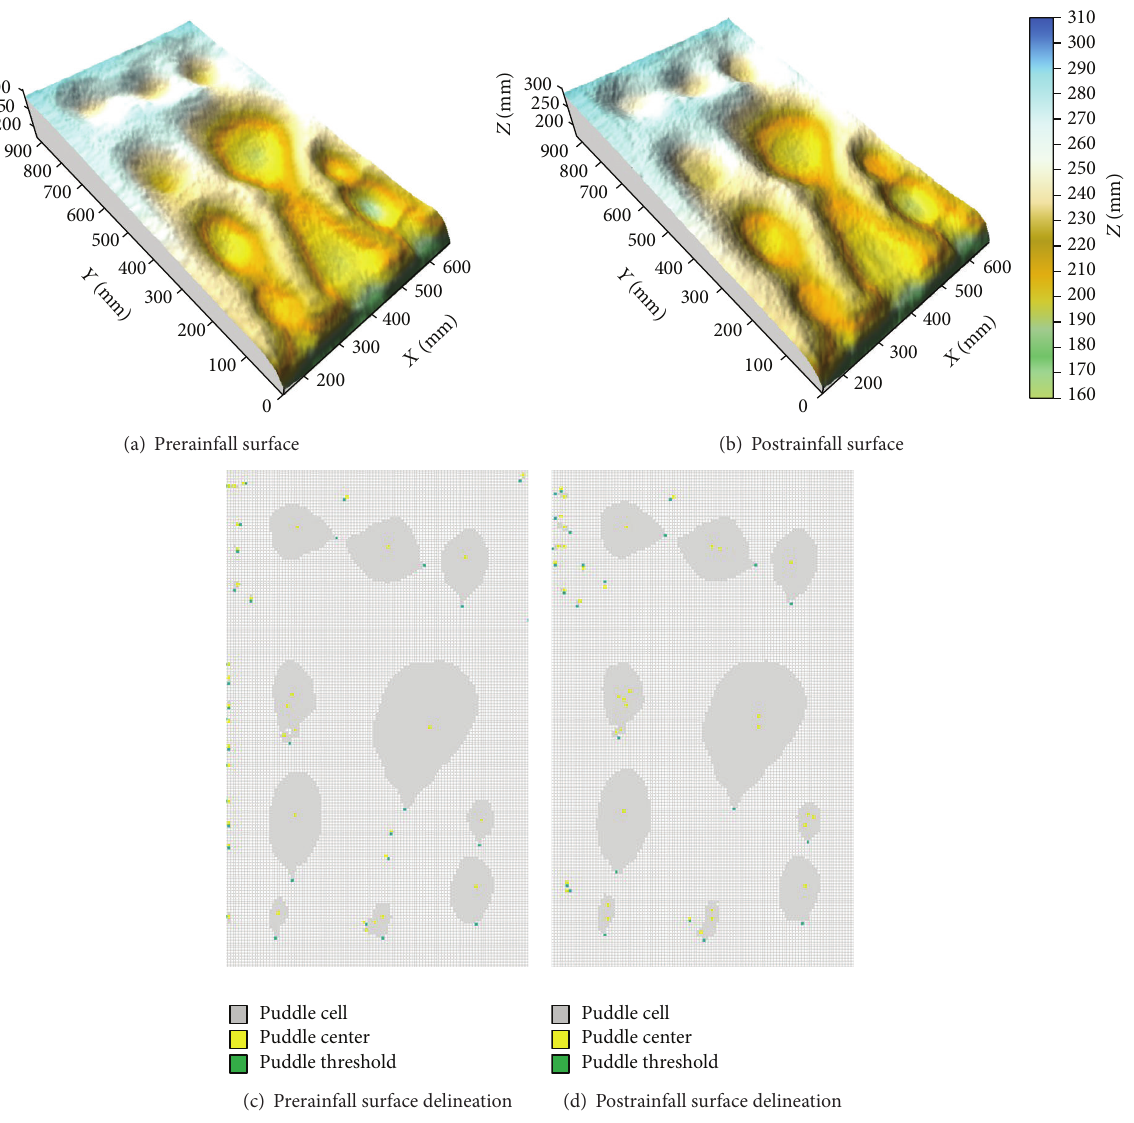
Figure 7: Comparison of pre- and postrainfall surfaces and their puddle delineation